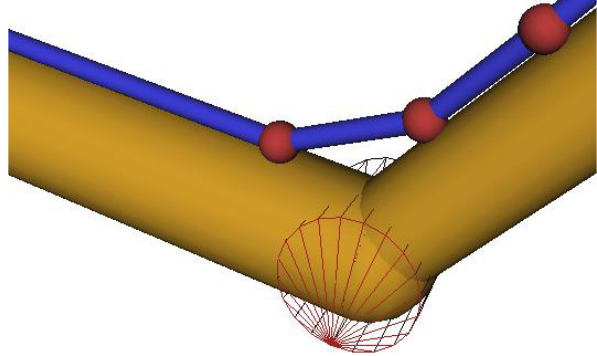
Figure 1. Illustration of tendon routing points (red spheres) as the tendon follows a revolute joint (wire frame